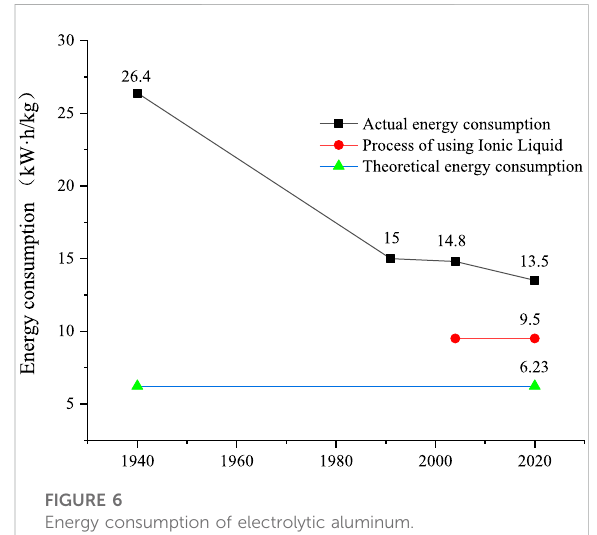
FIGURE 6 Energy consumption of electrolytic